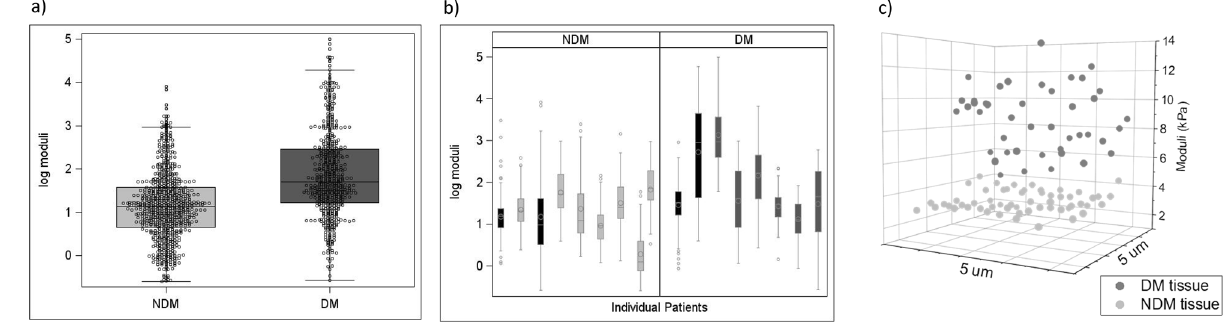
Figure 3. ( a ) Jitter plots of log-transformed elastic moduli of tissues from NDM and DM populations, center bar represents means, boxes represent interquartile ranges, and error bars represent standard deviations. ( b ) Box plots of log-transformed elastic moduli for individual subjects (subjects from each population that were measured twice are marked black) center circles represents means, boxes represent interquartile ranges, and error bars represent standard deviations. ( c ) Locoregional elastic moduli maps for two representative DM (dark grey dots) and NDM (light grey dots) 5 × 5 µm tissue samples. One dot represents a single elastic modulus value extracted from a 5 × 5 µm region of tissue.